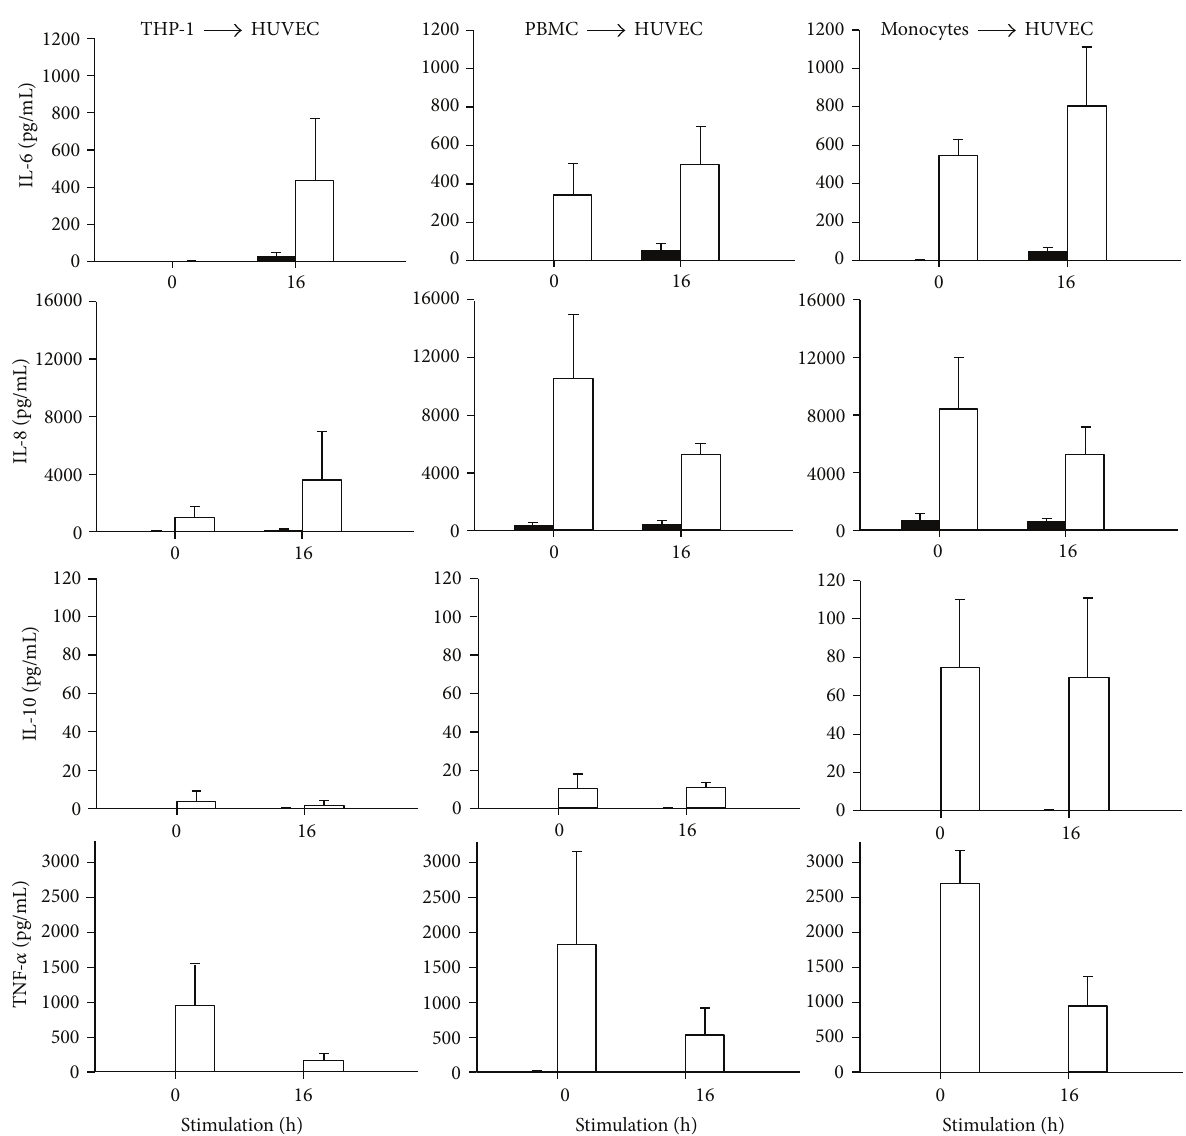
Figure 3: Effect of conditioned media on HUVEC. Conditioned media (white bars) derived from an 8h stimulation of THP-1, PBMC, or monocytes with LPS were applied onto HUVEC and the cytokine release was measured. Concentrations of IL-6, IL-8, IL-10 and TNF- 𝛼 are expressed as mean ± SD ( 𝑛 = 3 ). Black bars indicate control media without